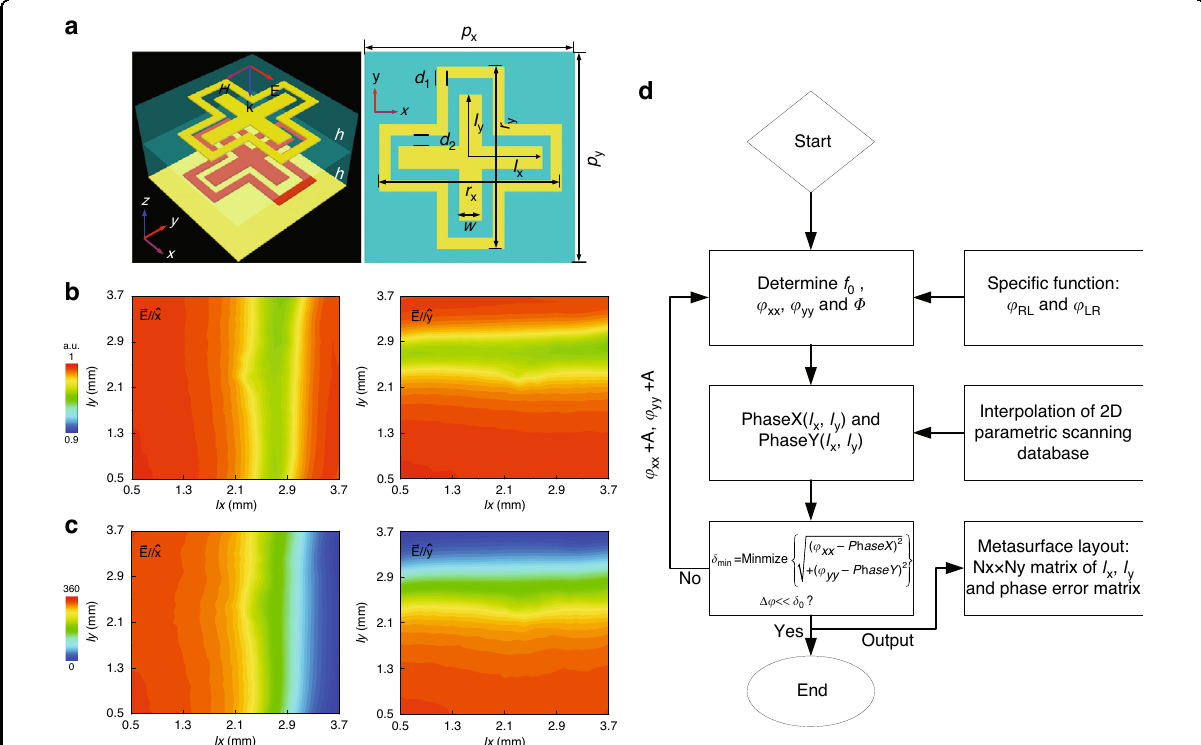
Fig. 2 Design of meta-atom and resulting metasurface. a Layout of the meta-atom. Numerically calculated b amplitude (| r xx | and | r yy |) and c phase ( φ xx and φ yy ) database at 10 GHz under x - and y -polarized wave. The residual geometric parameters for top dual-layer element are detailed as: